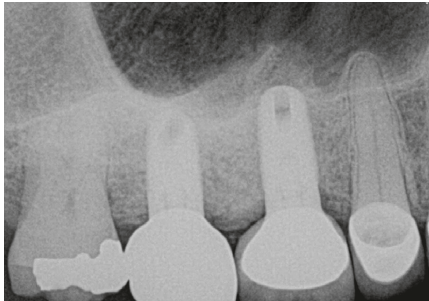
Figure 13: A periapical radiograph on the day of surgical de- bridement showing a 5 × 5 mm lack of bone density around the implant apex.